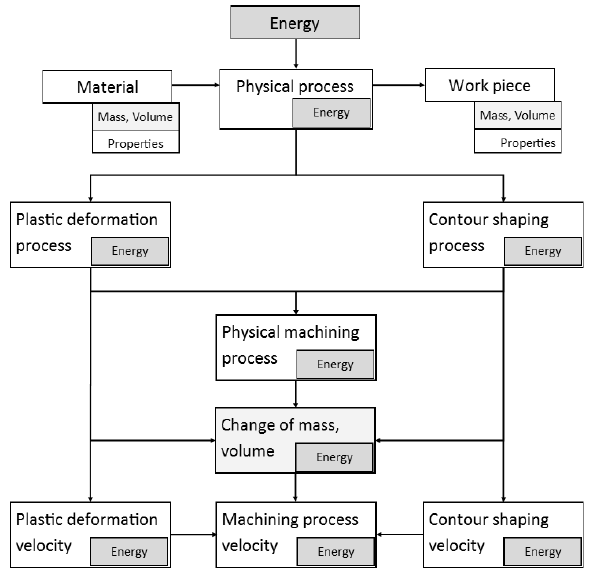
Fig. 4. Energetic model on energy transformation and material property change